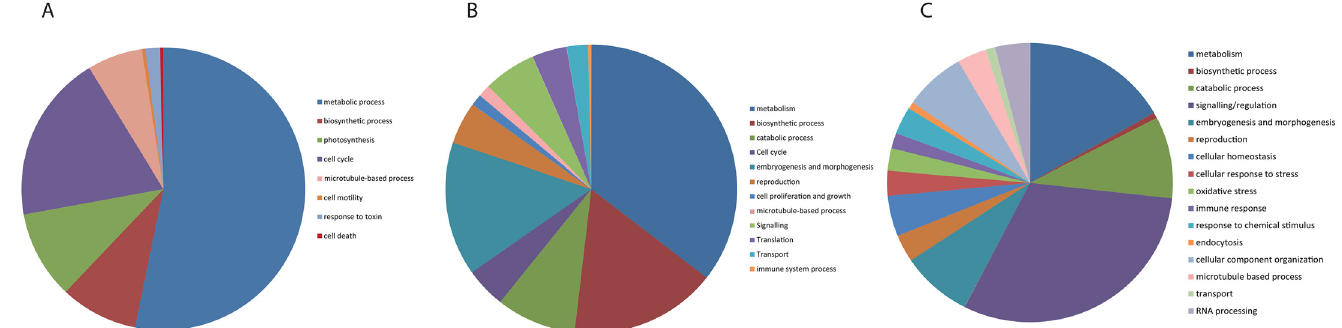
Fig 4. Gene enrichment analysis. Gene enrichment analysis (P < 0.05) of biological processes for differentially expressed genes in Acropora millepora holobiont exposed to Pre Industrial (PI) vs Present Day (PD) conditions (A) Representative Concentration Pathway RCP4.5 vs PD conditions (B) and RCP8.5 vs PD conditions (C). The program DAVID was used to test for enriched GO categories among differentially expressed genes. Each pie segment is annotated for specific GO category and the sizes of the pie segments are proportional to the total number of genes enriched.